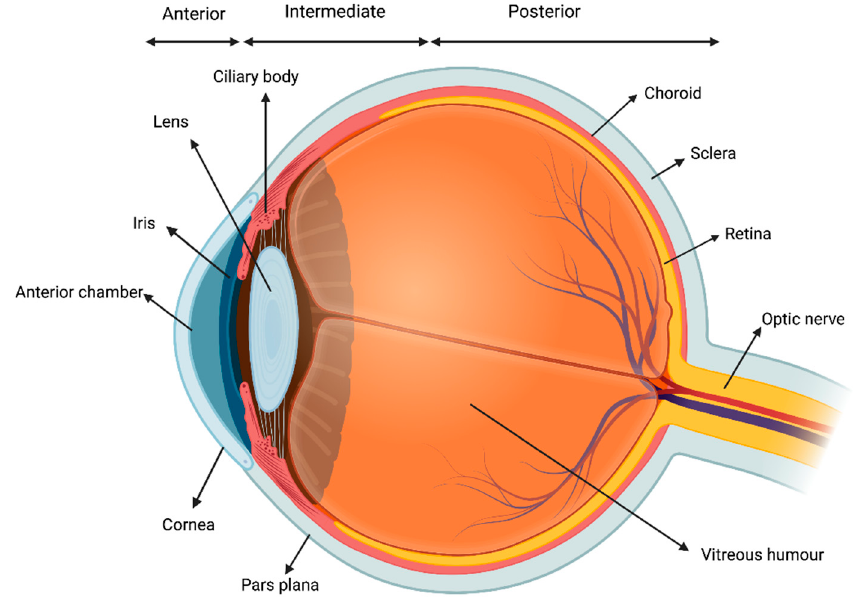
Figure 1. Visual representation of the uvea.